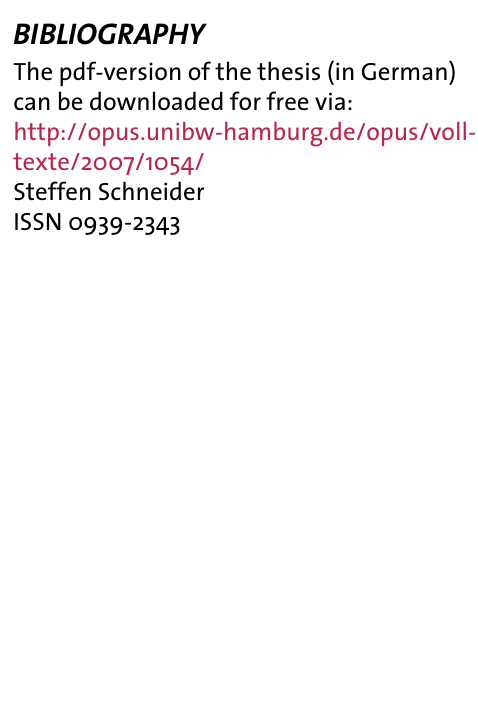
Figure 1: Differences in the results of the apparent flow curves between rheometer and flow channel (capillary rheometer). The applied field was DC for the flow channel while it was 100 Hz sine AC for the rheometer RS80 with E as the maxi- mum value. As expected, shear rate values are at a maximum at DC and decrease with increasing AC frequency. However, the discontinuity between the data sets implies more cor- rection is necessary to get comparable results from different test